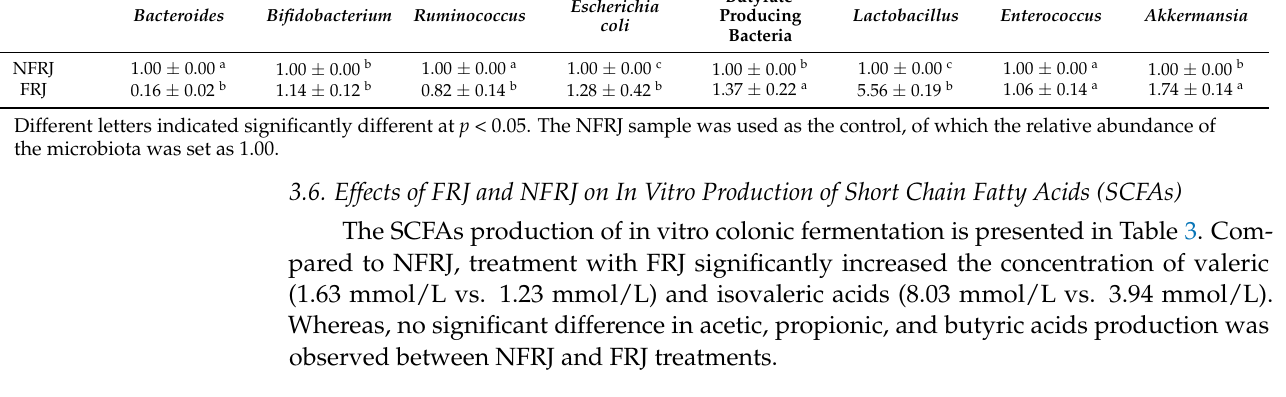
Table 3. SCFAs production of in vitro colonic fermentation with FRJ and NFRJ